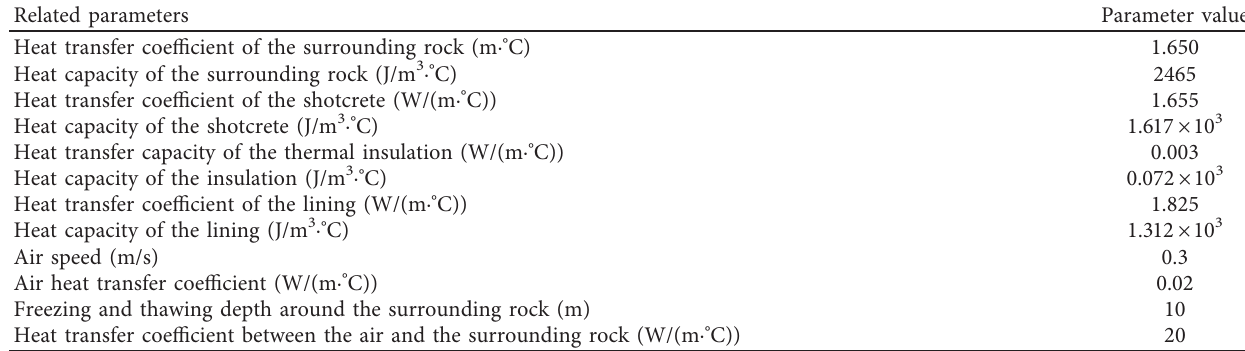
Table 3: Relevant parameters of the Fenghuoshan tunnel.